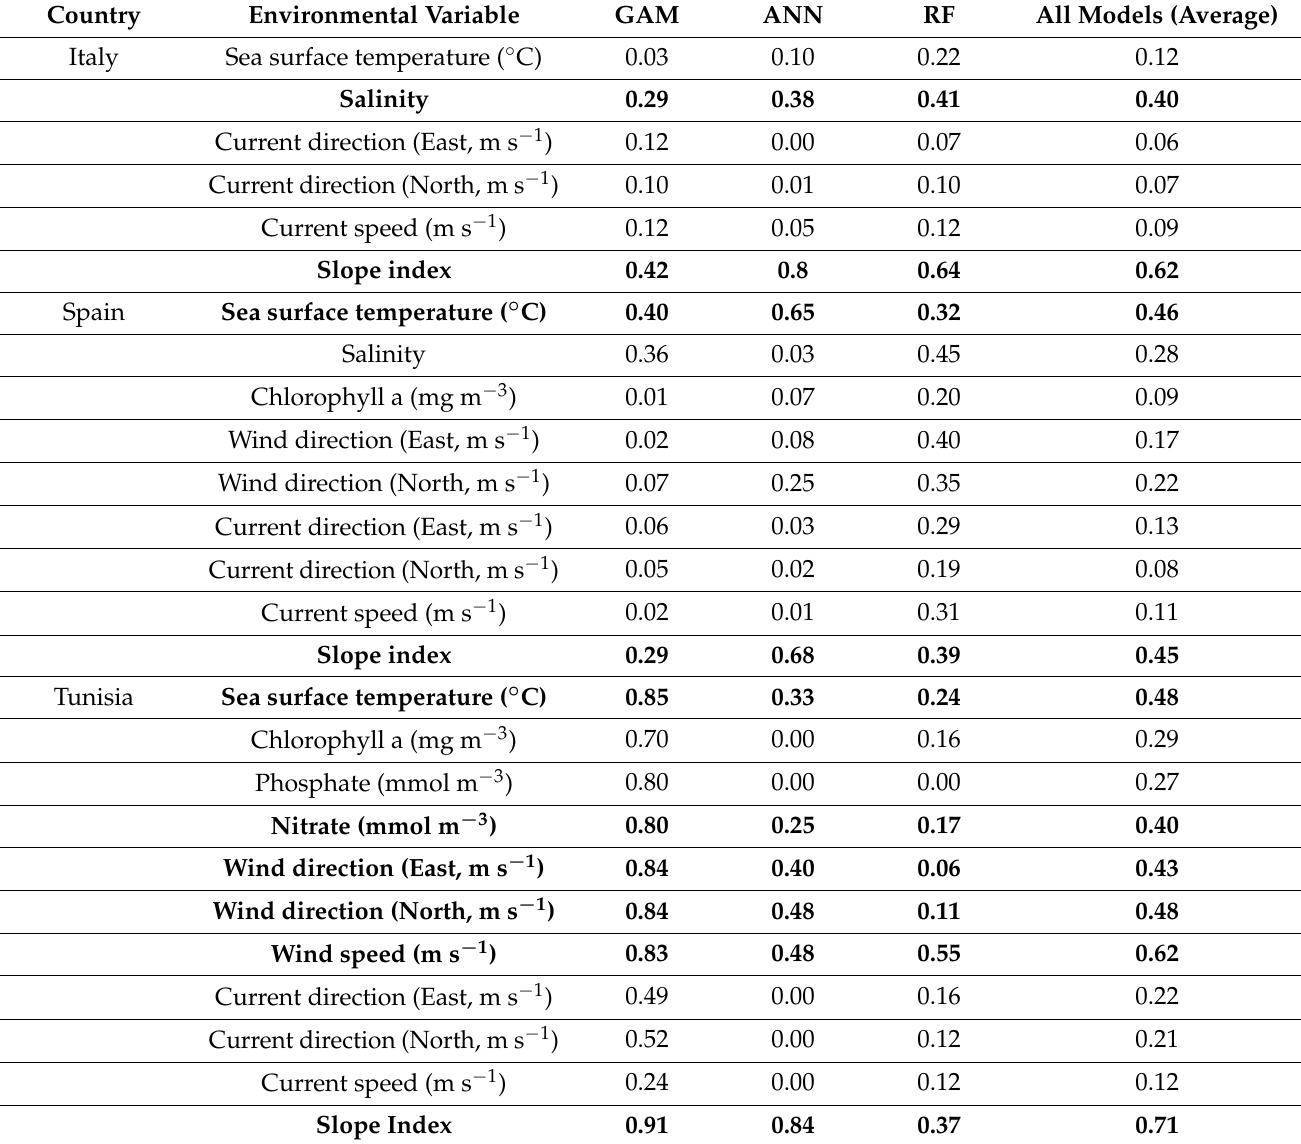
Table 3. Variable importance estimates for each explanatory variable for Rhizostoma pulmo distribution models. GAM: generalized additive model, ANN: artificial neural network, RF: random forest. Those variables with an importance estimate > 0.4 are highlighted in